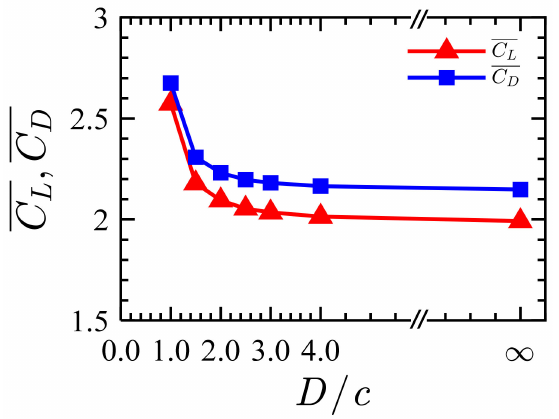
Figure 22. Cycled-averaged lift ( C L ) and drag ( C D ) coefficients for the first downstroke as a function of wall clearance ( D / c ) at Re = 100.